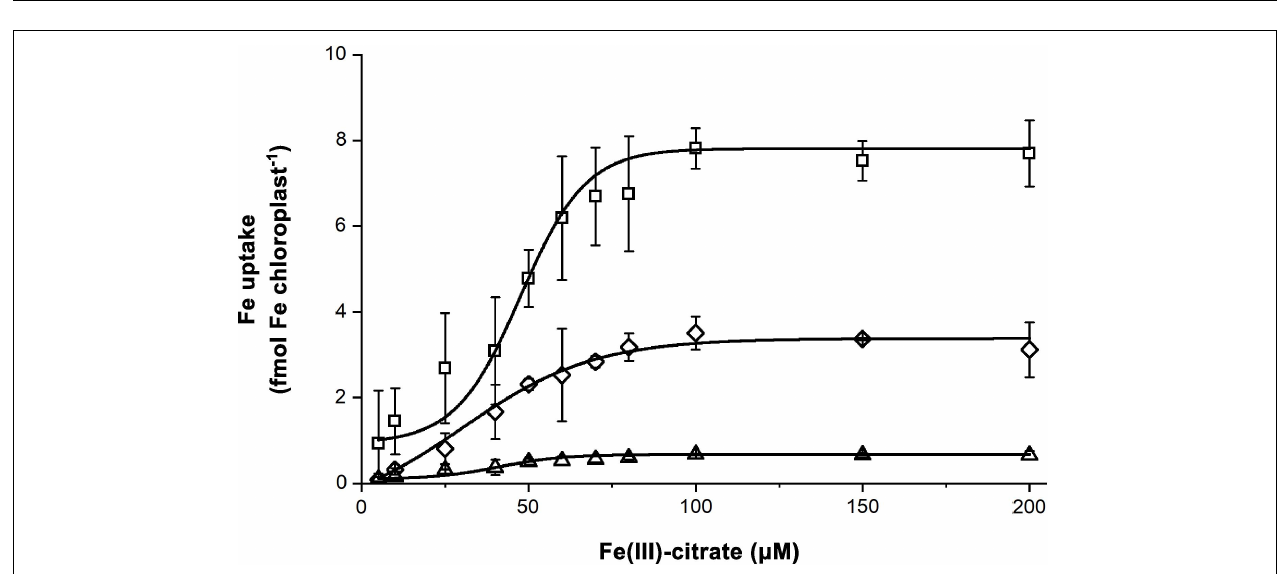
FIGURE 8 | Saturation of the Fe uptake of chloroplasts isolated from leaves of plants grown on Fe deficient (dFe—triangle), optimal (oFe—square) and supraoptimal Fe supply (sFe—diamond). Error bars represent SD values ( n = 12). Curves represent Boltzmann sigmoidal fits on datasets ( n =